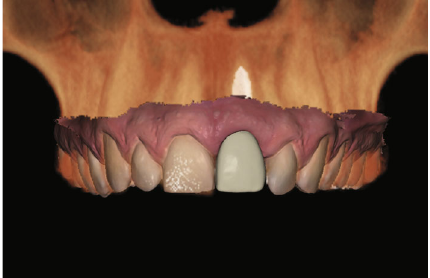
Figure 2: Digital set-up of the upper left central incisor, based on a superimposed intraoral scan and CBCT